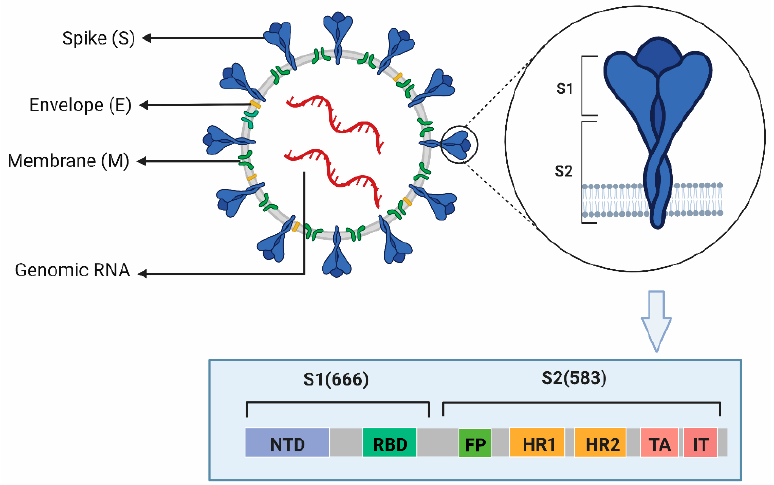
Figure 2. The structure of SARS-CoV-2. (This Figure was created with BioRender software. https://biorender.com/).